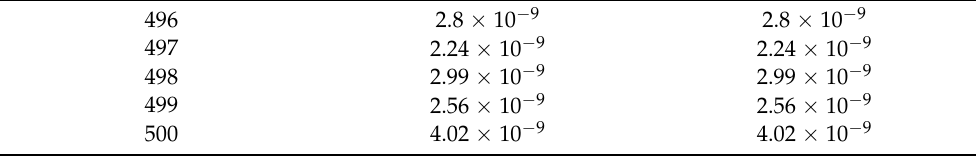
Table 7. ARCH (1) conditional variance for global foreign exchange market